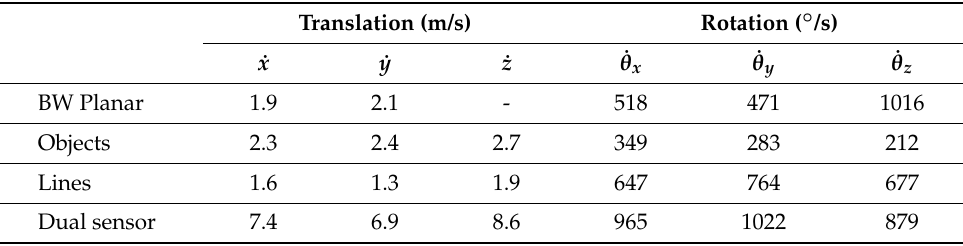
Table A2. The maximum speed registered from the largest oscillations present in each of the test